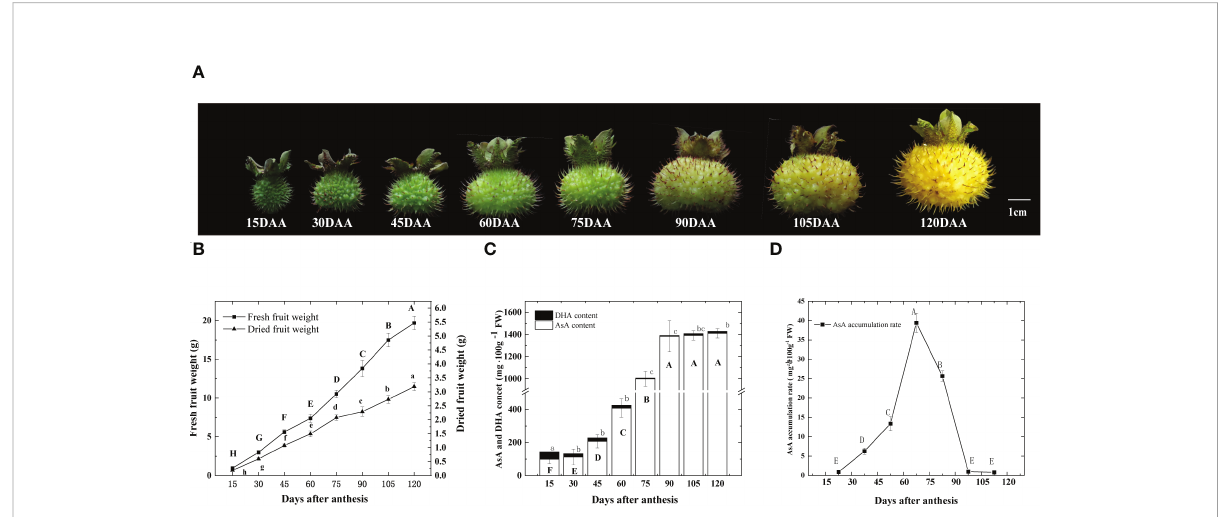
FIGURE 1 Changes of R. roxburghii fruits during the development. (A) Fruit phenotypic changes, (B) dynamic changes of single fruit weight, (C) DHA and AsA content and (D) the rate of AsA accumulation during the development of R. roxburghii fruit. Values are means of 4 replicates ± SD. AsA accumulation rate = average increase in AsA content every day, taking the median point of adjacent time as the time node. Different letters denote statistical signi fi